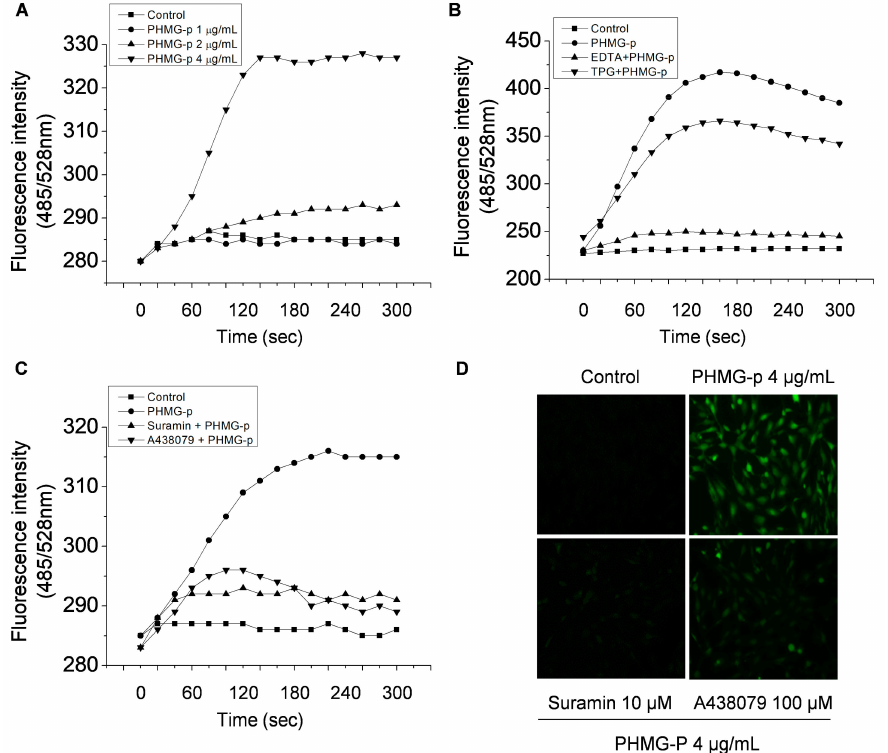
Figure 3. PHMG-p induces intracellular Ca 2 + influx via P2RX7. Cells were treated with 1–4 µ g / mL PHMG-p ( A ); 0.5 mM ethylenediaminetetraacetic acid and 1 µ M thapsigargin, followed by incubation with 4 µ g / mL PHMG-p ( B ); or 10 µ M suramin and 100 µ M A438079, followed by 4 µ g / mL PHMG-p ( C , D ). Cells were assessed by Fluo-4 NW staining at 20-s intervals for 5 min ( A – C ) and visualized by fluorescence microscopy ( D